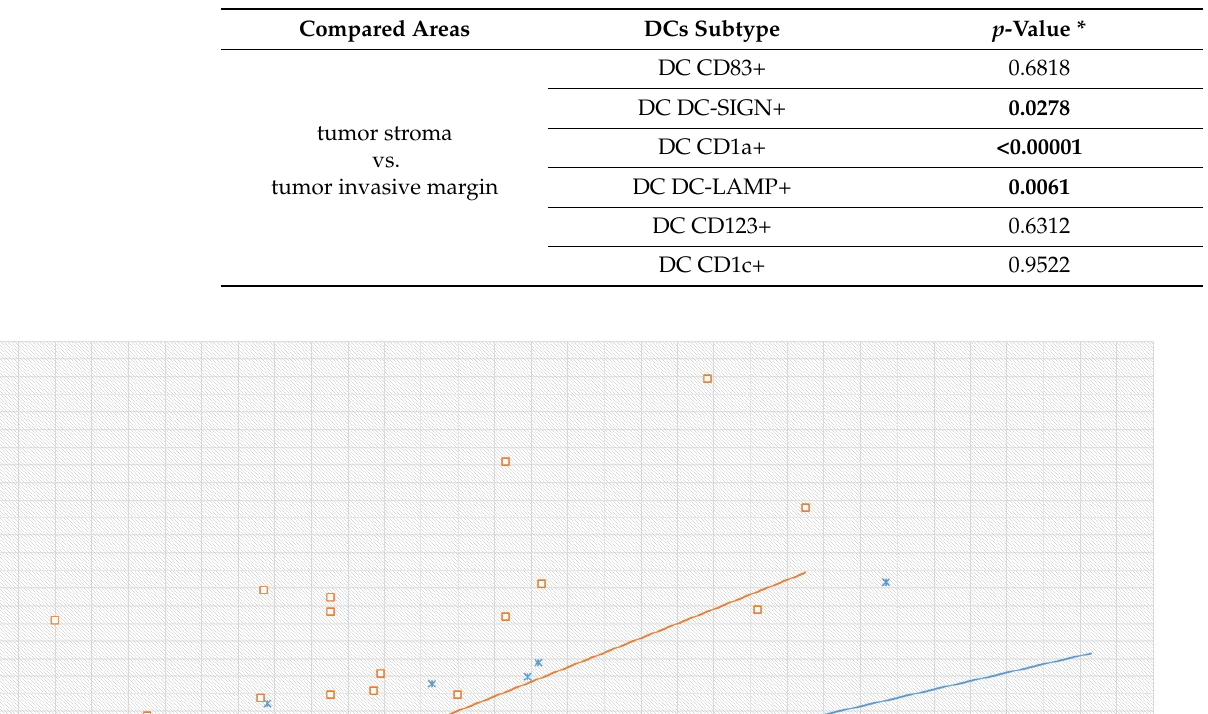
Table 2. Differences in numbers of different DC subtypes between ECs’ stroma and invasive margin. For DCs positively stained for DC-SIGN, CD1a, and DC-LAMP, the tumor stroma was significantly more heavily infiltrated by DCs than its invasive margin. The statistics were calculated using the Mann–Whitney U test (* p < 0.05 was considered statistically significant).